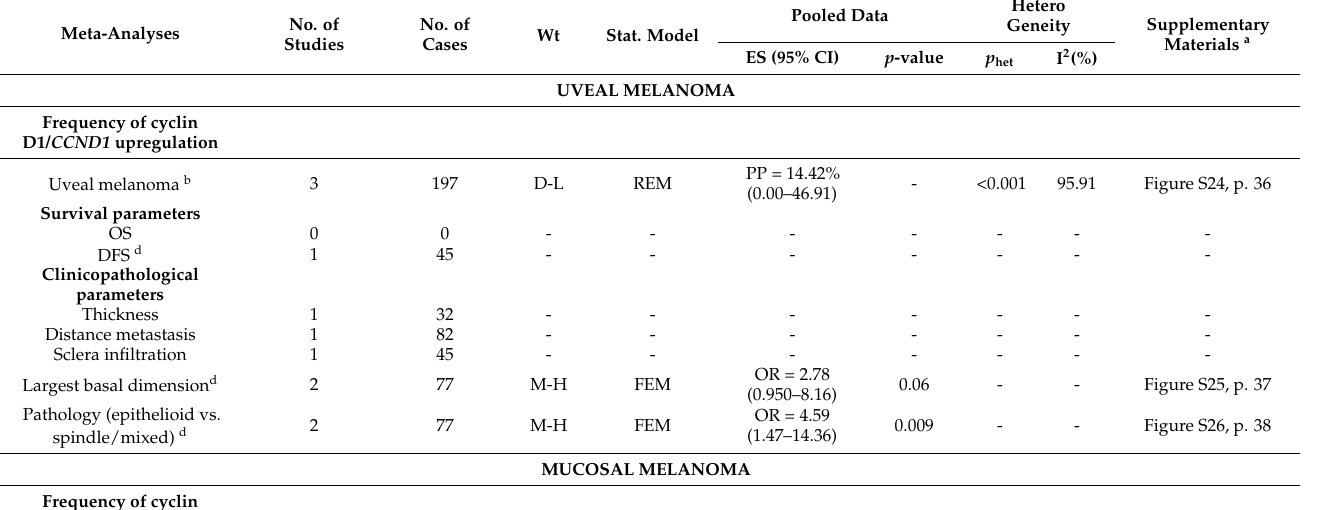
Figure S29, p. 41